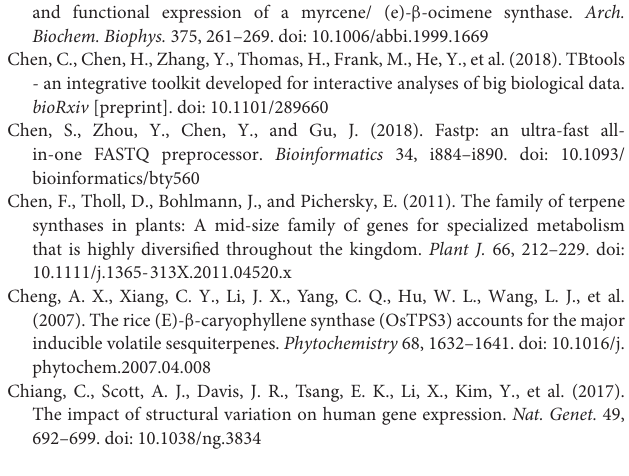
Supplementary Figure 1 | Gene structure of the TPSs overlapped with SVs. (A–H) Were the gene structure of TPS2, TPS8, TPS11, TPS14, TPS 17, TPS21, TPS28, and TPS45